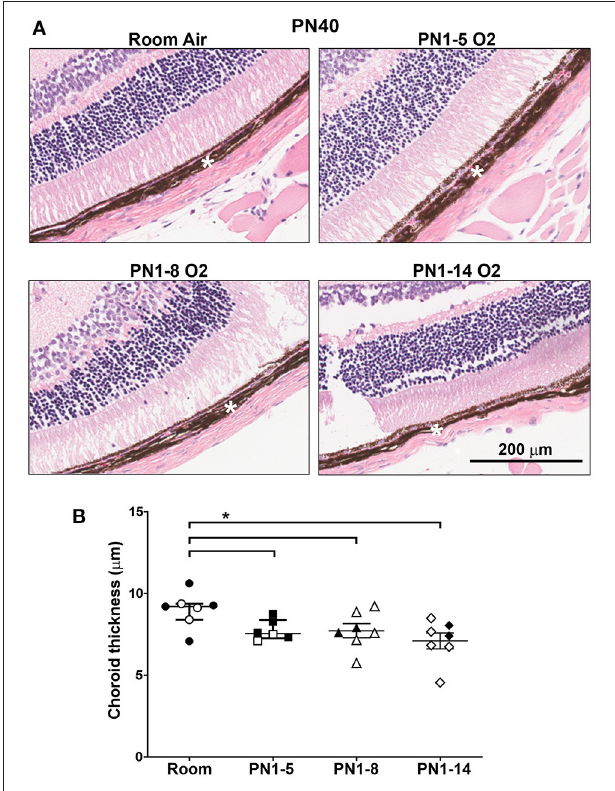
FIGURE 5 | Choroidal thinning in young adult mice exposed to prolonged oxygen in infancy. (A) Representative H&E photomicrographs of sections depicting choroid (white asterisk) at PN40 comparing C57BL/6 room air control mice and the indicated oxygen-exposed mice. Images were taken with 10x objective using Aperio ScanScope CS. Scale bar = 200 µ m. (B) Quantitation of choroidal thickness (asterisk) of eye sections shown in (A) . All data are presented as median ± IQR and assessed using Mann-Whitney U -test (2-tailed); * P < 0.05. n ≥ 6 mice per group, with 2L used in the analysis of each oxygen group. Gender is represented by closed (male) and open symbols (female). PN, postnatal. The retinas were obtained from the same mice used to assess lung pathology in other figures. Outliers were removed using a ROUTS outlier